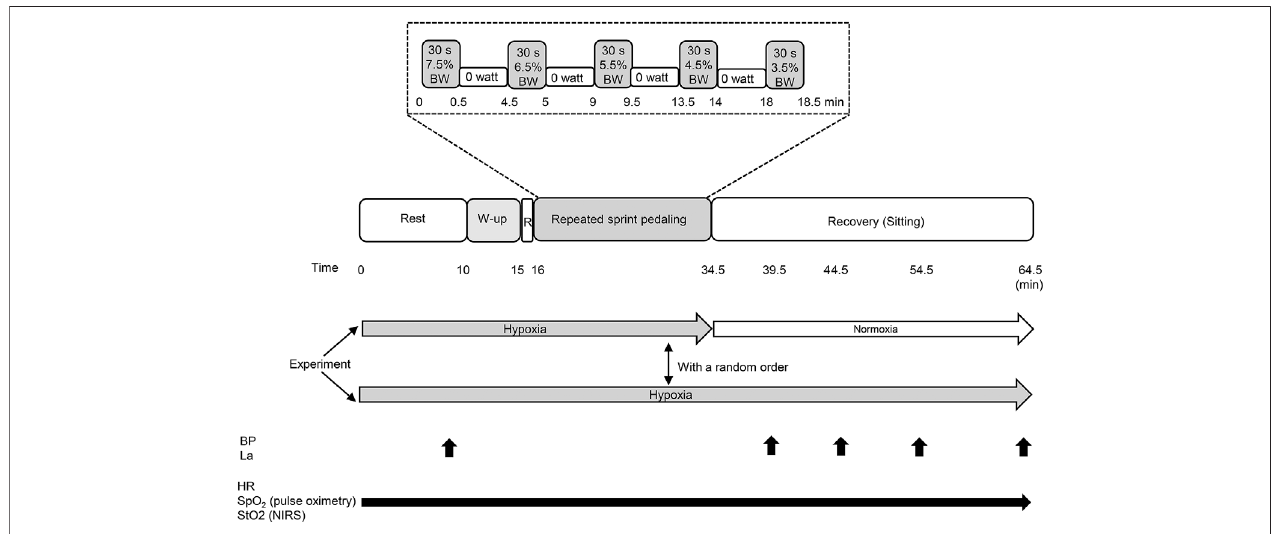
FIGURE1| Experimental protocol ofthe present study. BW,body weight;W-up, warm up;R, rest; BP,blood pressure;La, blood lactate concentration; HR,heart rate; SpO 2 , arterial oxygen saturation; StO 2 , tissue oxygen saturation. Black arrows indicate the measuring points and periods.